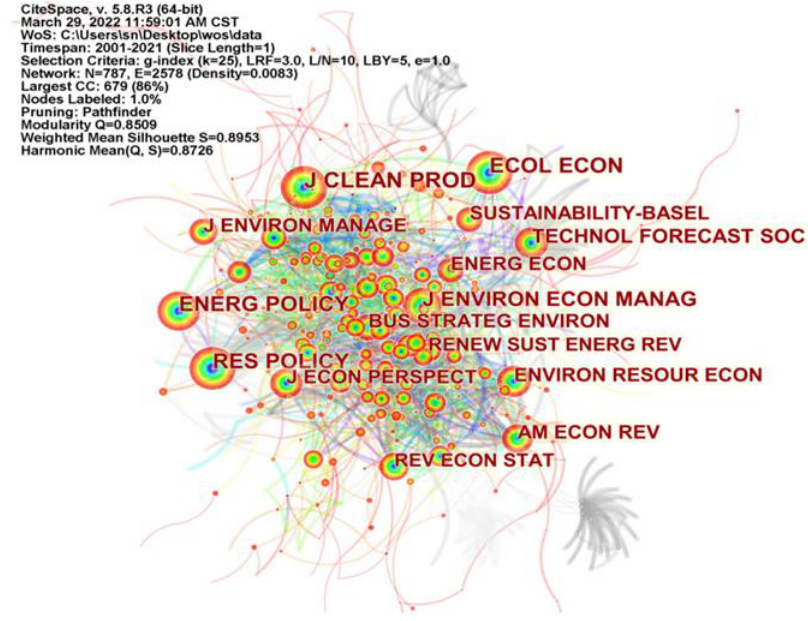
Figure 7. CiteSpace-based journal co-citation mapping. Table 6. Top 10 co-cited journals.